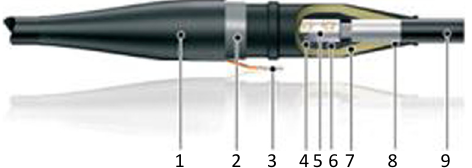
Fig. 2. Cable joint cross-sectional